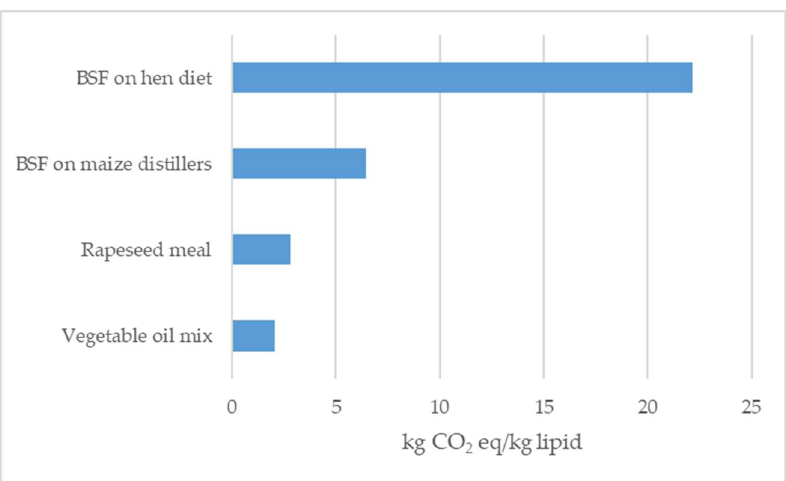
Figure 5. Climate change estimation to produce 1 kg of lipids from BSF larvae production (on different substrates) from two types of vegetable feed (a rapeseed meal and vegetable oil mix).